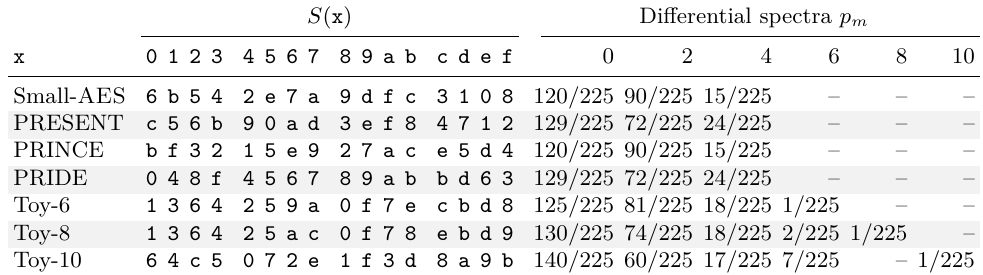
Table 5: Properties of the employed S-boxes and differential spectra. S ( x ) Differential spectra p